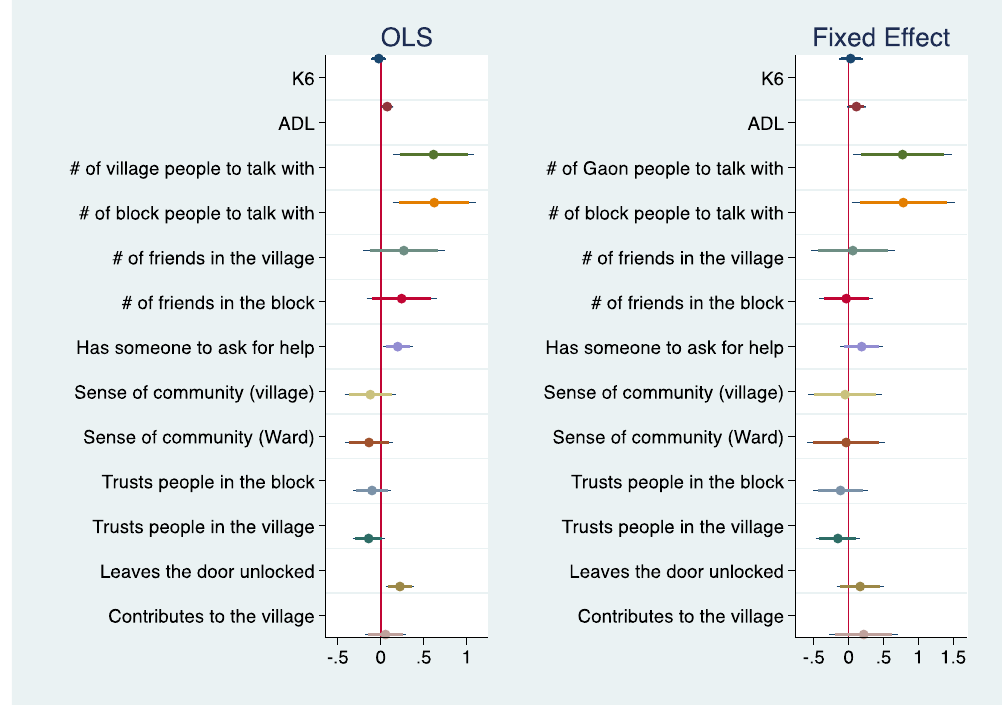
Figure 3. The impact of Ibasho participation on selected outcomes (Nepal). Note : The graph summarizes the coefficient on Ibasho participation for each outcome after controlling for age, gender, years of living in the community, marital status, working status, academic degree, monthly household expenditure, family type, and housing situation as well as round